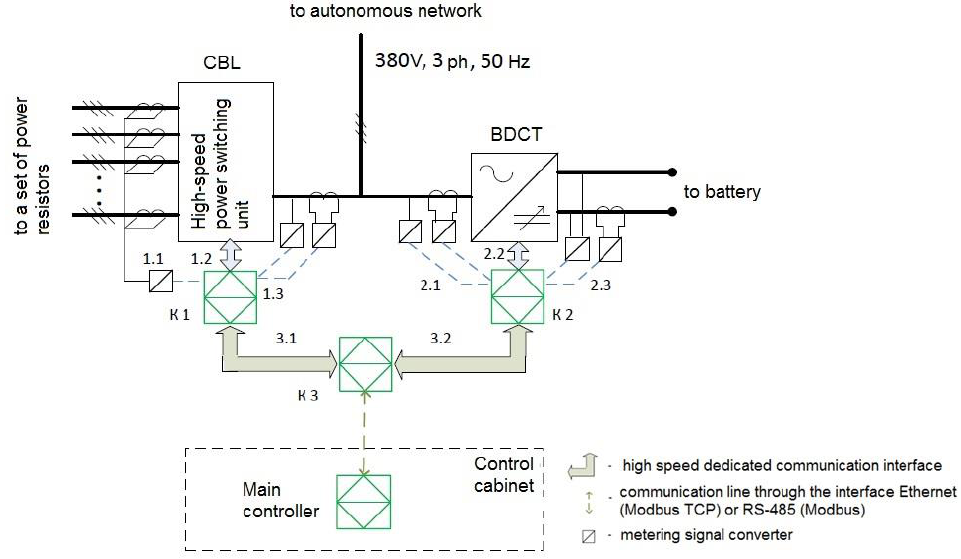
Figure 2. The “conversion, control and energy distribution” module of hybrid energy systems. K1: dump load controller; K3: common module controller; K2: bi-directional current transducer controller; 1.1: control stage current; 1.2: control circuits and internal power control circuits; 1.3: control and measurement of output electrical parameters; 2.1: control and measurement of output electrical parameters; 2.2: control and management circuit of the internal power circuit of the bi-directional current transducer; 2.3: control and measurement of electrical parameters on the battery side.